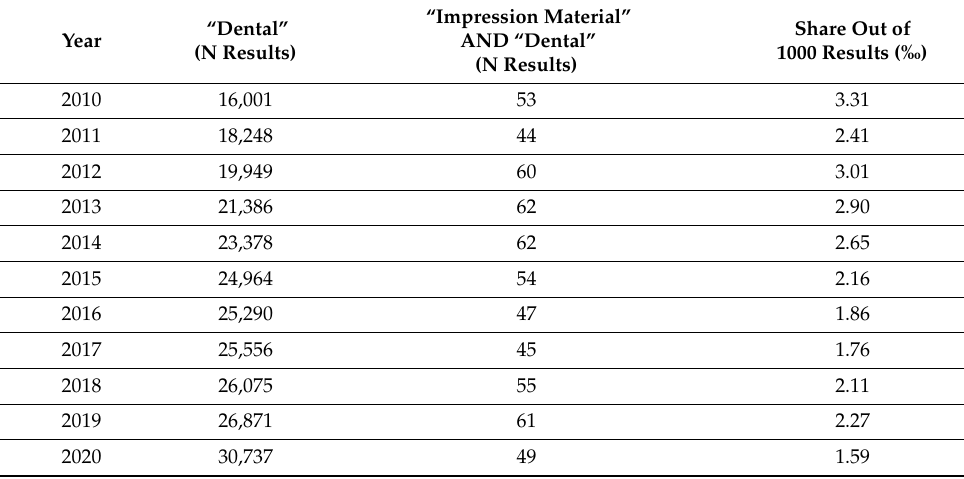
Table A1. Annual results when searching “impression material” And “dental” in Pubmed